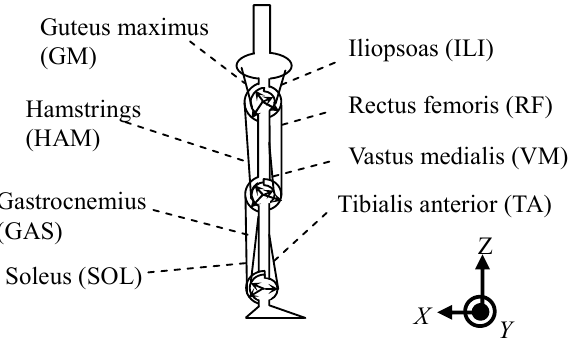
Fig. 3 Musculoskeletal model of calculation part for muscle force